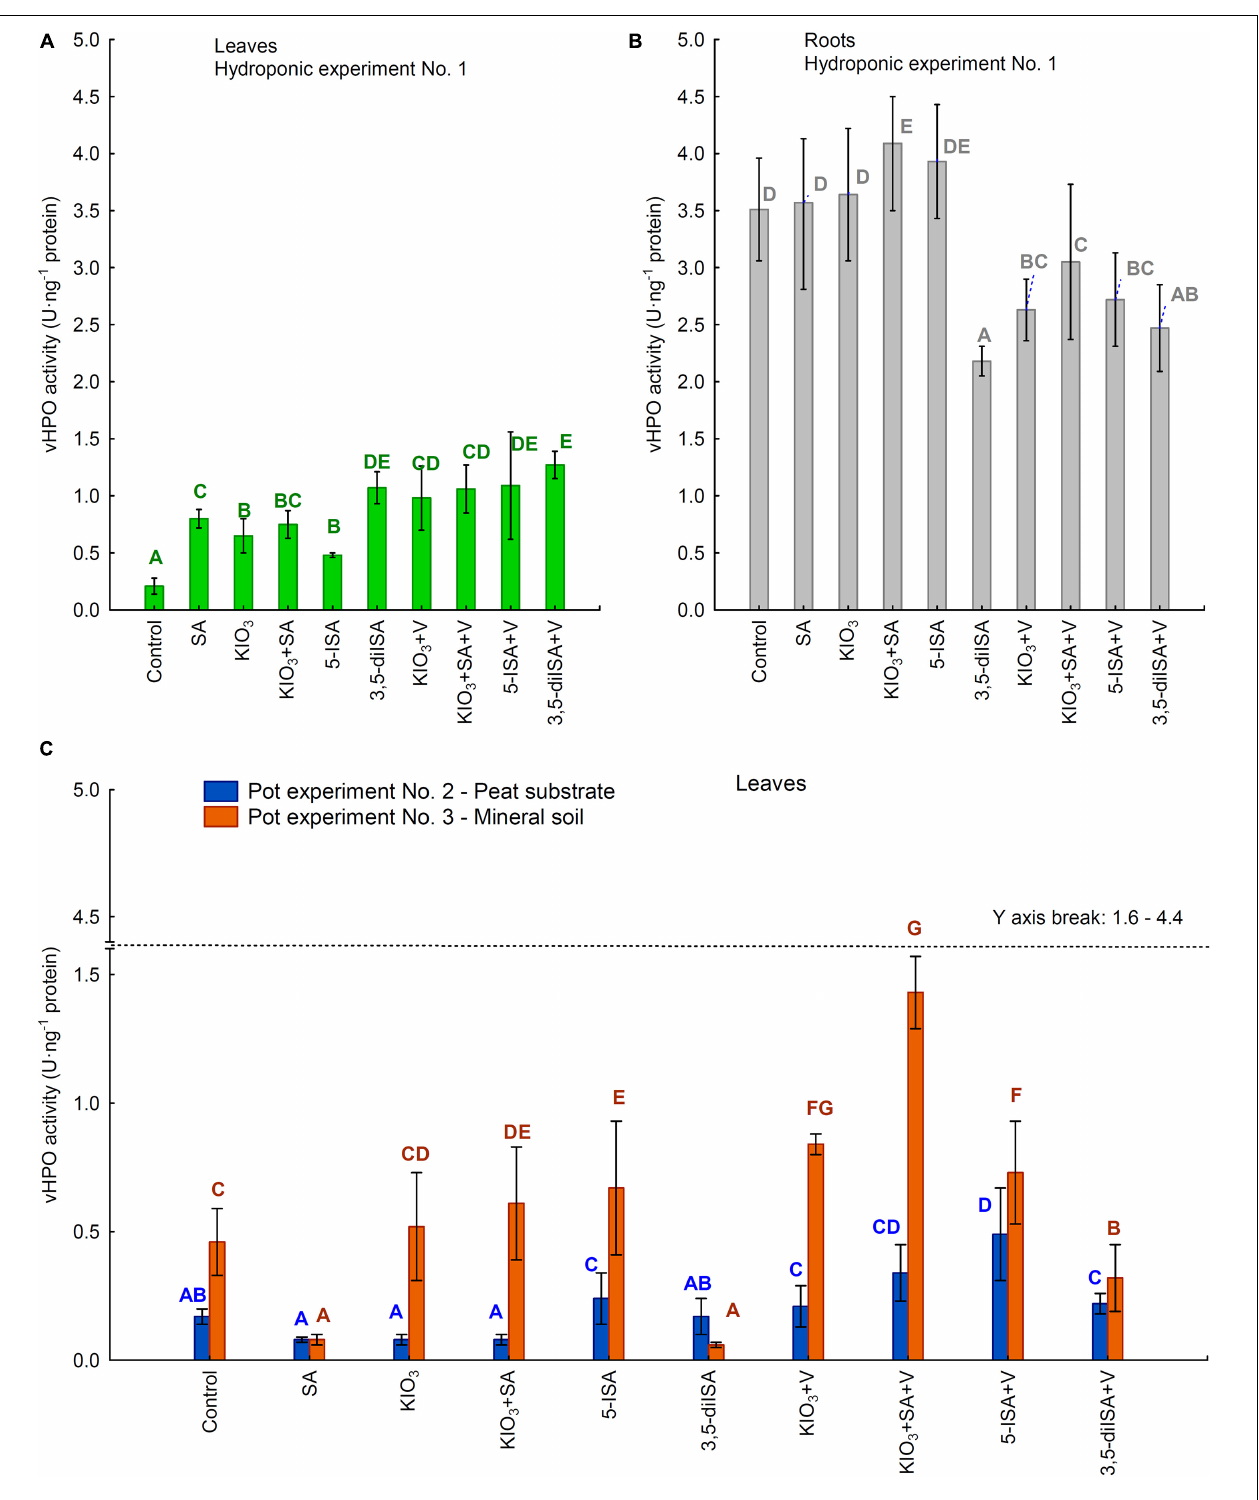
FIGURE 4 | Activity of vanadium-dependent haloperoxidase (vHPO) in leaves /heads/ (A) and roots (B) of lettuce cultivated in hydroponic NFT Experiment No. 1 as well as in leaves of plants cultivated in pot Experiment No. 2 and 3 (C) . Means followed by different letters for treatments, separately for each experiments differ significantly at P < 0.05. Color-coded capital letters for vHPO activity—green and gray for leaves and roots in Experiment 1 and blue and orange for leaves in Experiments 2 and 3. Bars indicate standard error ( n = 8).